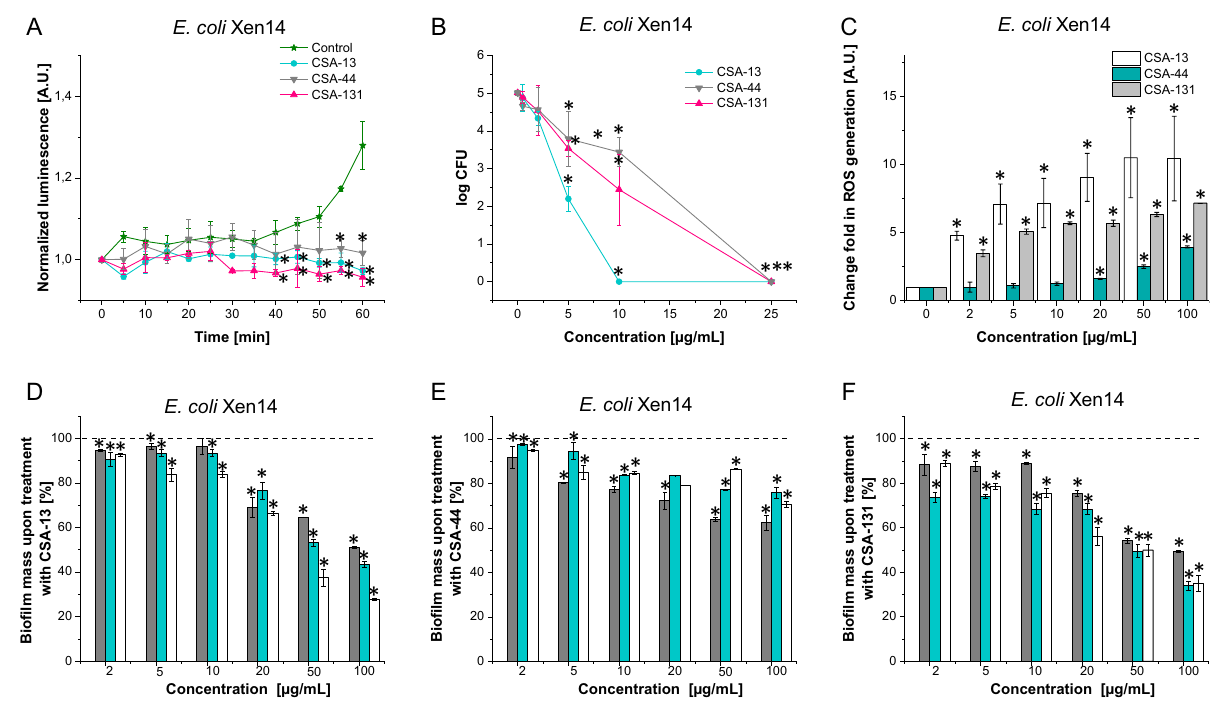
Figure 1. Antibacterial activity of ceragenins (CSA-13, CSA-44 and CSA-131) against E. coli Xen14. Decrease of bacteria-derived luminescence signal upon 1 h treatment with tested ceragenins. Results are presented as mean ± SD from 3 replicates ( A ). Decrease of survival of E. coli Xen 14 planktonic bacteria when exposed to ceragenin CSA-13, CSA-44 and CSA-131 evaluated using the “killing assay” method. Results are presented as mean ± SD from 3 replicates ( B ). Induction of reactive oxygen species (ROS) generation by E. coli Xen14 was evaluated by DFCH-DA fluorometric assay. Formation of ROS upon treatment with CSA-13, CSA-44, and CSA- 131 at a concentration of 1–100 μg/mL was presented. Results are presented as mean ± SD from 3 replicates; *indicates statistical significance ≤ 0.05, ** ≤ 0.01, and *** ≤ 0.001 ( C ). Anti-biofilm properties of CSA-13 ( D ), CSA-44 ( E ), CSA-131 ( F ) against E. coli Xen14. Ability of ceragenins to prevent the biofilm formation of E. coli was measured using crystal violet staining upon 24 (grey bars), 48 (green bars) and 72 h (white bars). Results are presented as mean ± SD from 3 replicates. Dashed horizontal line indicate untreated control (0 µg/mL of